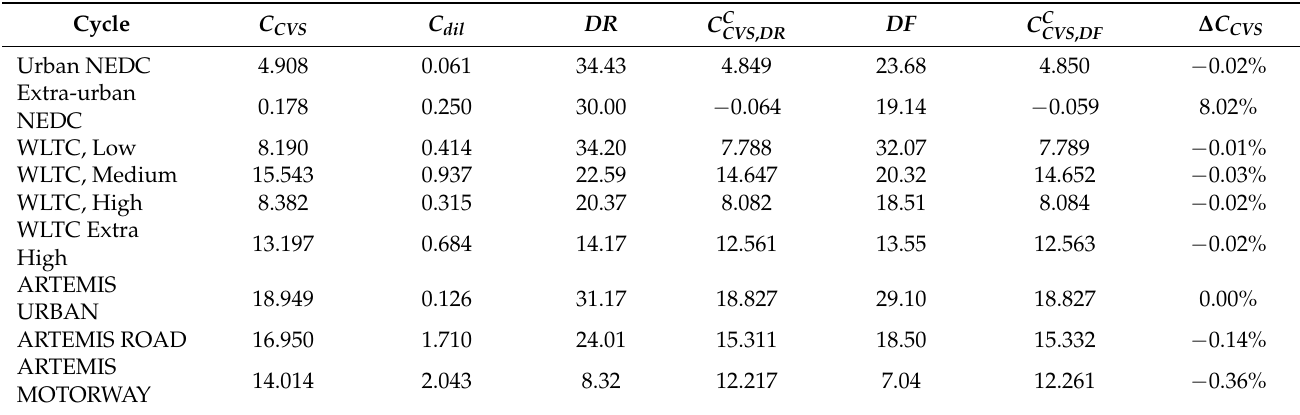
Table A13. The C CVS,corr calculated based on Equations (5) and (21) for Euro 6 WLTP vehicle with SI engine, NO x concentration [ppm].